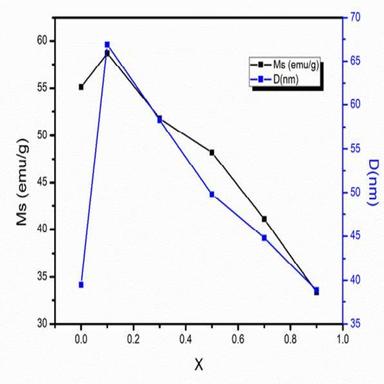
hows the effect of substitution on saturation magnetism and crystal size, the saturation magnetism as well as in crystals size increases upto x=0.10 beyond that both saturation magnetism and crystals size decreases upto x=0.9. The above study reveals that saturation magnetism along with structure properties and substitution also depends on crystallite size.